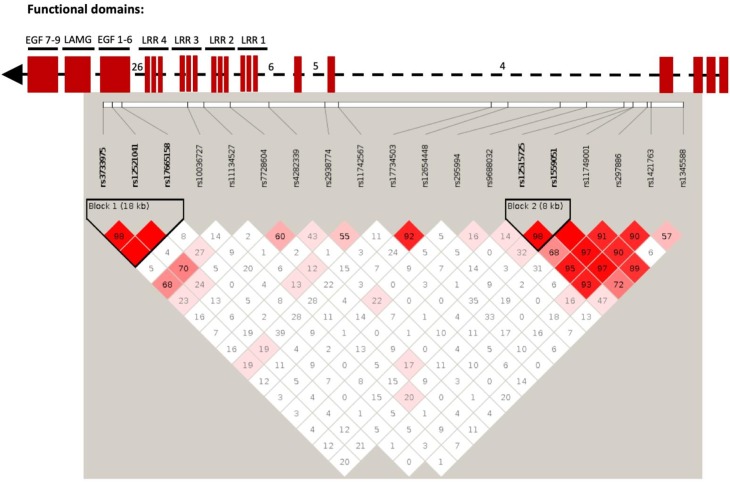
Linkage disequilibrium (LD) plot of SLIT3 SNPs in human smoking association analysis.Numbers within each square indicate D’ values (white: D’<1, LOD <2; blue: D’=1, LOD <2; pink: D’<1, LOD ≥2; and bright red: D’=1, LOD ≥2). Top part of the figure shows domain organization of the SLIT protein based on the UCSC Genome Browser (http://genome.ucsc.edu/) in relation to the SNP location. LRR: leucin-rich repeats. EGF: epidermal growth factor domains. LamG; Laminin G domain. Some intron numbers were added for reference.